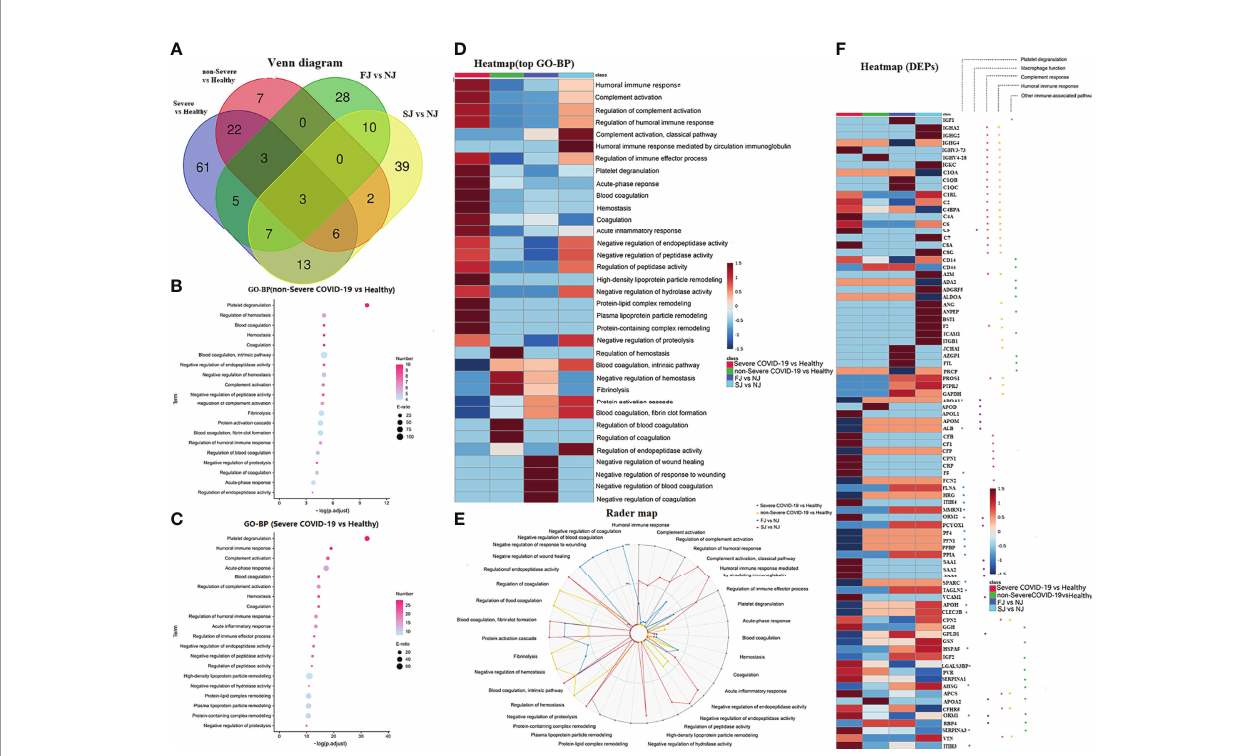
FIGURE 7 | Comparison of DEPs and their enriched pathways in severe COVID-19 infection, non-Severe COVID-19 infection, FJ and SJ group. (A) Venn diagram showing the number of DEPs from severe COVID-19 vs healthy, non-Severe COVID-19 vs healthy, FJ vs NJ and SJ vs NJ. (B) GO-BP analysis of DEPs from non- Severe COVID-19 vs healthy. Top 20 GO-BP terms were expressed. (C) GO-BP analysis of DEPs from severe COVID-19 vs healthy. Top 20 GO-BP terms were expressed. (D) Heatmap of the top GO-BP terms enriched from DEPs in severe COVID-19 vs healthy, non-Severe COVID-19 vs healthy, FJ vs NJ and SJ vs NJ. (E) Radar map of the top GO-BP terms enriched from DEPs in severe COVID-19 vs healthy, non-Severe COVID-19 vs healthy, FJ vs NJ, and SJ vs NJ, respectively. -Log 10 p values of GO-BP terms were used to make the radar map. (F) Heatmap of DEPs from vaccination and infection that were related to platelet degranulation macrophage function, complement response, humoral immune response and other immune-associated